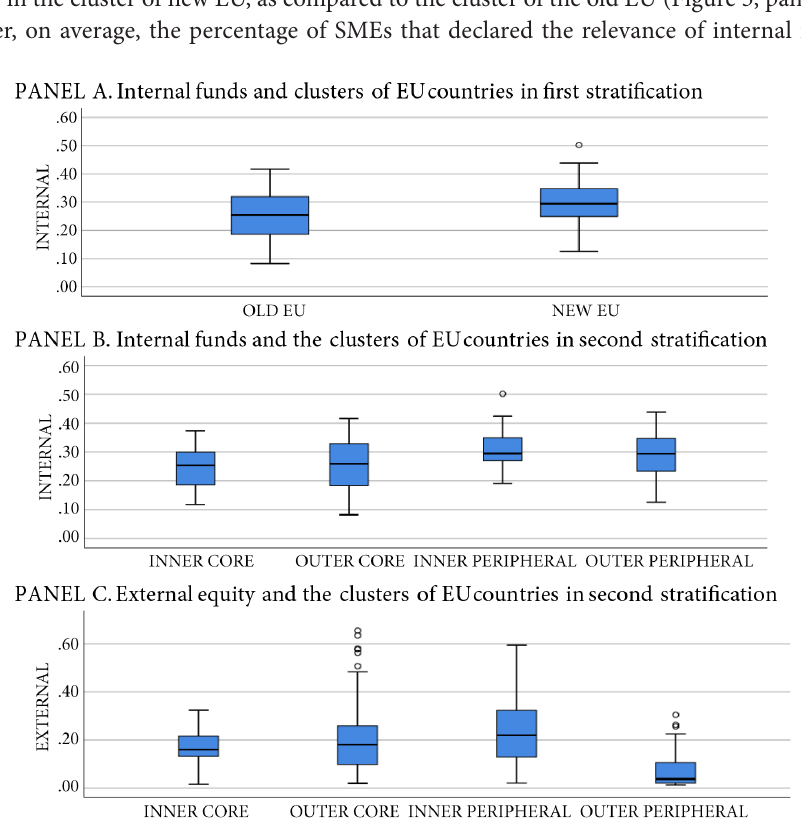
Figure 5. The boxplots for significant differences between the clusters of EU countries in terms of equity financing (extension of Kruskal-Wallis